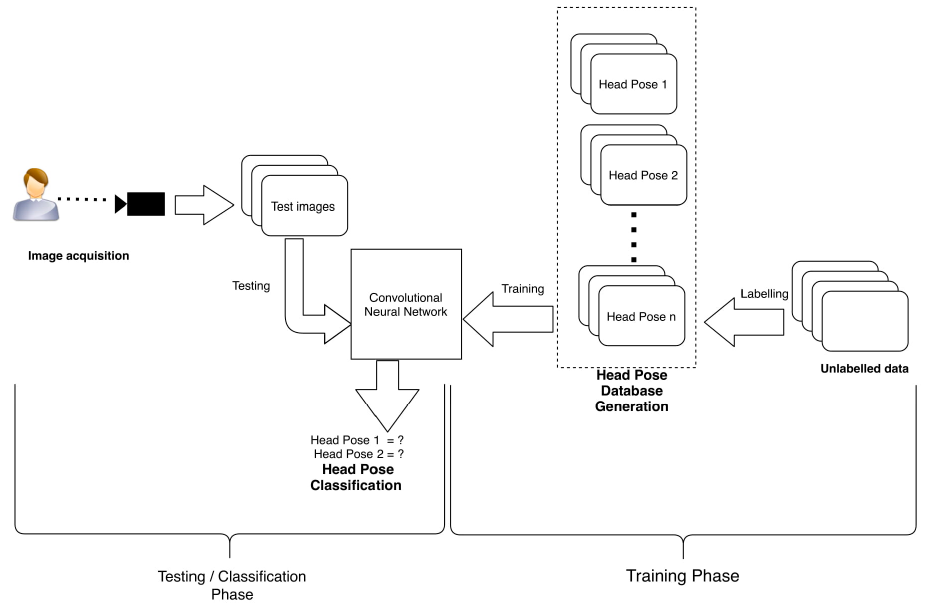
Figure 5 . System flow diagram of the KiliRo robot. Figure 5. System flow diagram of the KiliRo